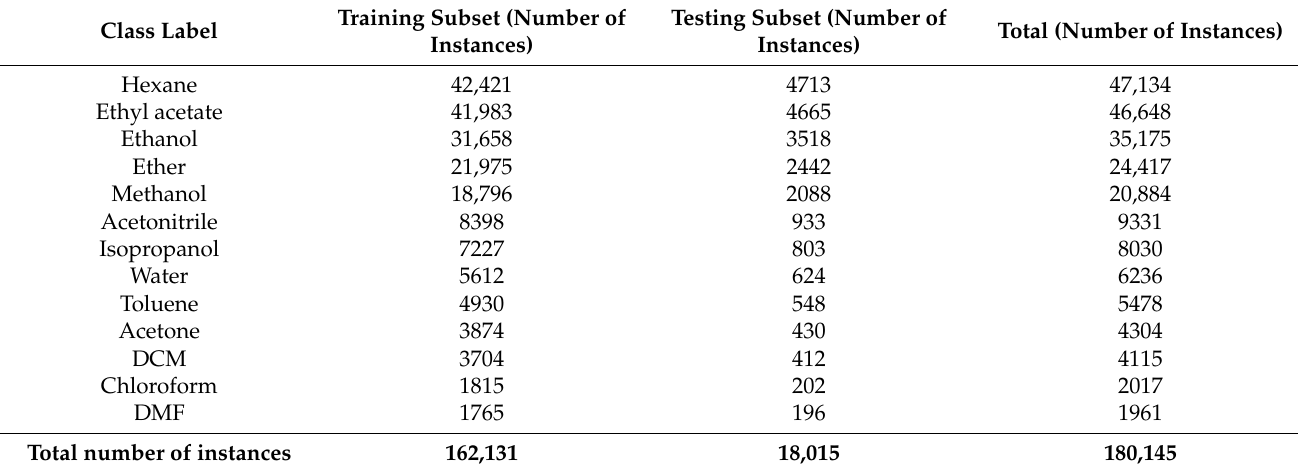
Table 2. Distribution of instances over different class labels (DS1 and